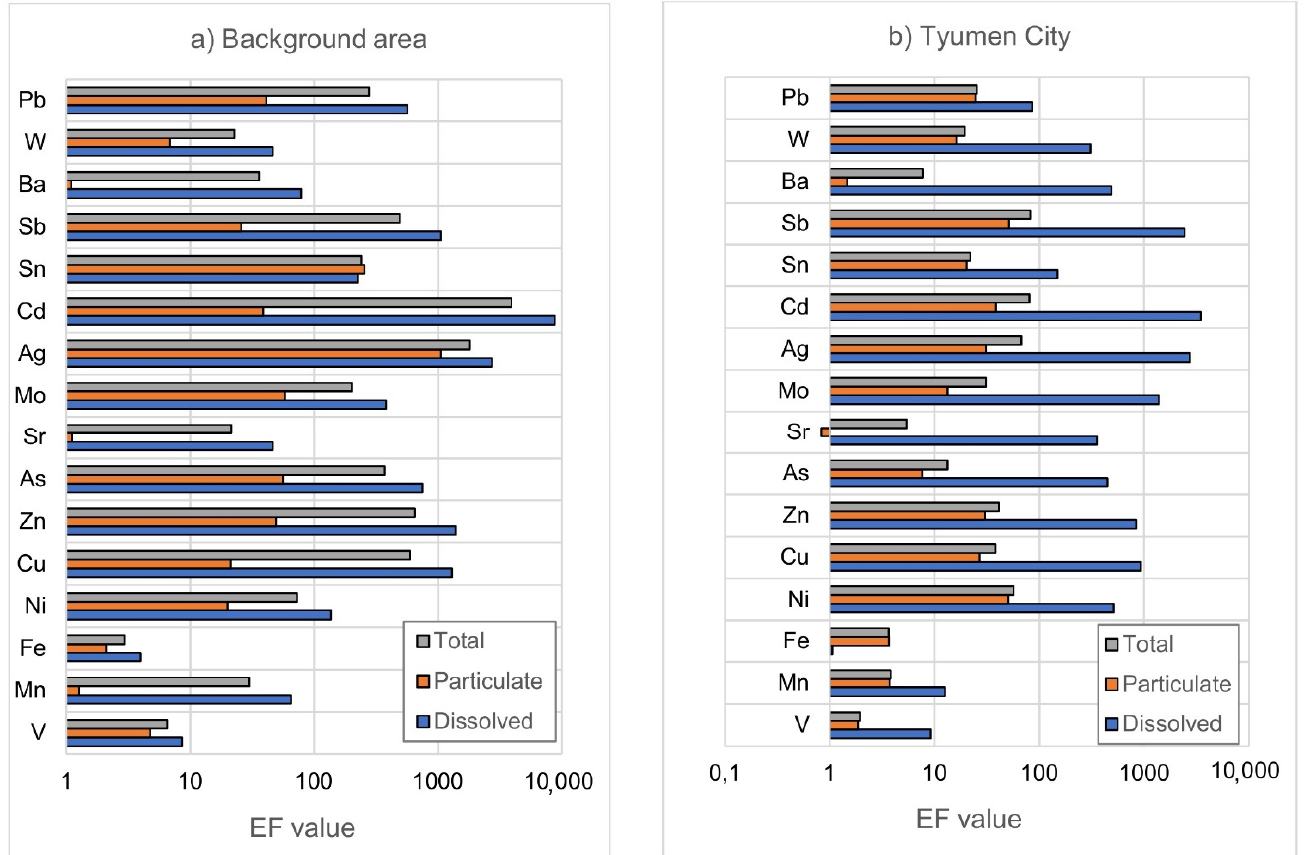
Figure 5. The enrichment-factor values of TMMs in the background area ( a ) and Tyumen City ( b ). Similar results were obtained in the study by Shevchenko et al. [11] showing that snowpack within Western Siberia has a range of EF values, 1–5 (Fe) to more than 1000 (Sb, Zn and Cd). The enrichment of aerosols in Cd and Zn due to manmade pollution has been detected in many studies in different parts of the globe. Kim et al. [70] noted that Asian and non-Asian dust was strongly or extremely polluted by Cd, Zn, Pb, Cu and As. Dong et al. [71] reported that Zn and Cd were clearly enriched (EF values >100) in surface snow and a snow pit on the Northern Tibetan Plateau of China. In the snow of Teheran (Iran), maximal EF values are reported for Zn, Pb and Cd [72]. In Southern China, atmospheric aerosols are enriched in Se, Cd, Zn, Pb, As, Mo and Cu (EF > 100) [46]. The nonferrous metal industry makes a significant contribution to the emissions of Cd, Zn Pb and Cu into the environment [73]. As discussed above, high concentrations of Pb and Cd in the snow- pack around Tyumen City are connected with the wind transportation of polluted air from the Urals, which is the largest metallurgical and metal processing center [66]. Based on the EF values of the TMMs deposited with the snowpack of Tyumen City (Figure 5b), we can distinguish three groups of elements as follows: (1) low enriched (EF 1–10) elements (Rb, Fe and V) sourced from soils; (2) moderately enriched (EF 10–100) elements (W, Ba, Sr, Ni, Co, Cr and Mn) that originate from mixed soil-anthropogenic sources; and (3) highly enriched elements (Pb, Sb, Cd, Ag, Mo, As, Zn and Cu) with EF values > 100, reflecting an important contribution from anthropogenic sources. Pollution within Tyumen City was primarily associated with local sources. The main source of Pb and Sb emissions in Tyumen was the storage battery plant, around which these elements were found in highest concentrations. Until very recently this plant pro- duced storage batteries from lead-antimony alloys containing Pb, Sb, As, Bi and Sn [74]. It is well known that vehicle emissions and road dust resuspension can be an essential source of Pb, Sb, Cu, Ni and other metals [75–77]. However, leaded gasoline has been